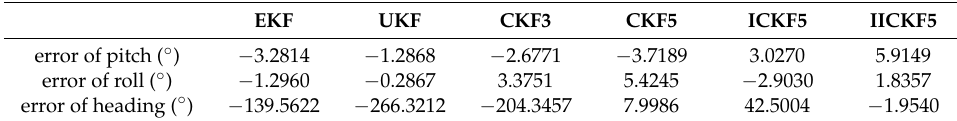
Table 2. Comparison of alignment errors with in-motion base ( ◦ ).